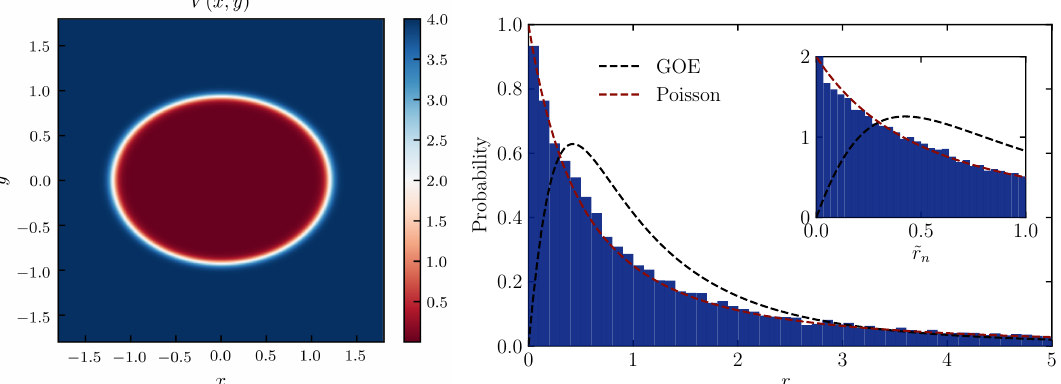
Figure 11: Distribution of the ratio of consecutive level spacings . Left: The sym- metric potential representing a smoothened elliptic confining potential (93). Right: Histogram of the ratio of the consequent difference of the (logs of) eigenvalues (see Eq. (90)) of the canonical distribution W for a particle in this potential. See also